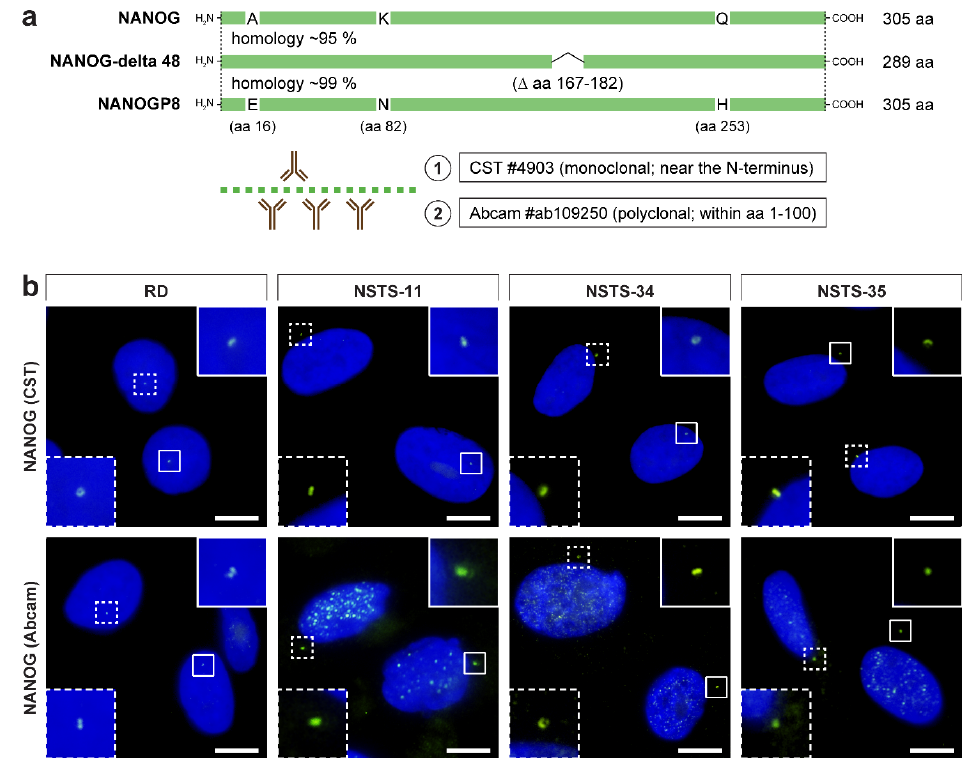
Figure 1. Overview of epitopes of the anti-NANOG antibodies used in this study and their detection of the perinuclear localization of NANOG in rhabdomyosarcoma cell lines. ( a ) Schematic illustration of NANOG isoforms and the NANOGP8 paralog and overview of epitopes of the anti-NANOG antibodies used in the study: (1) #4903, Cell Signaling Technology (CST) and (2) #ab109250, Abcam. Note the marked homology of the NANOG and NANOGP8 protein sequences in the protein region, which served as the immunogen for producing the anti-NANOG antibodies. ( b ) NANOG protein (green) was detected in the cytoplasm near the cell nucleus in the form of one or two punctae using two anti-NANOG commercial antibodies (#4903, Cell Signaling Technology (CST) and #ab109250, Abcam). The nuclei were counterstained with Hoechst 33342 (blue). For each image, regions of interest and the respective close-ups are indicated by the dashed and solid boxes. Scale bars, 10 μ m.